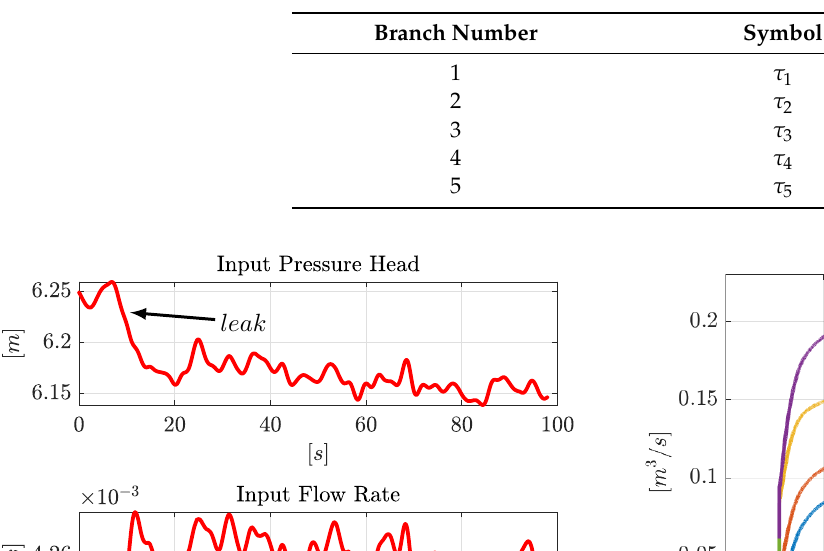
Table 3. Friction factors for each branch.